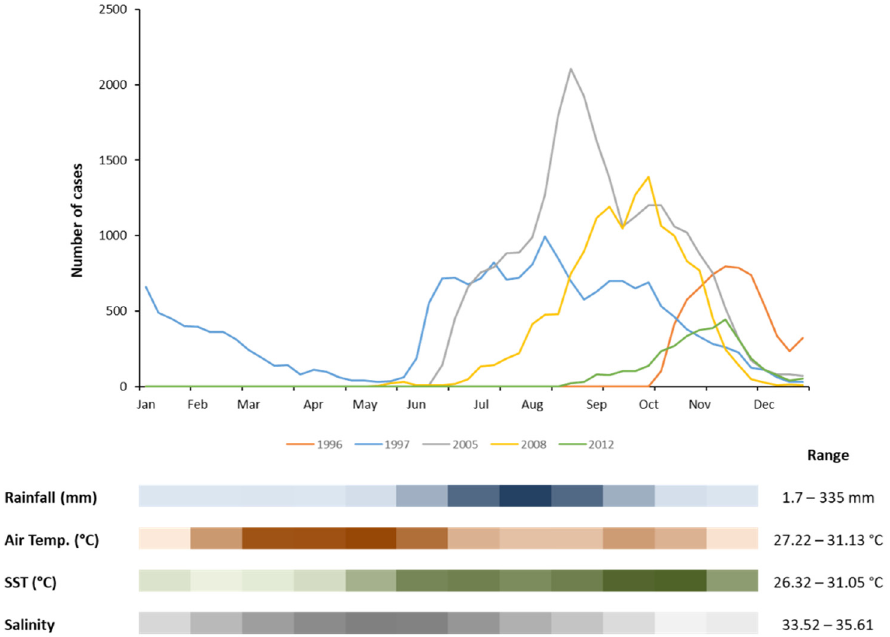
Figure 3. Weekly number of cholera cases during the major epidemics occurring in Guinea-Bissau between 1986 and 2013. Heat map (ascending color gradient) showing average monthly rainfall (blue), air temperature (brown), sea surface temperature (SST, green), and salinity (grey) over the 27–year time series.